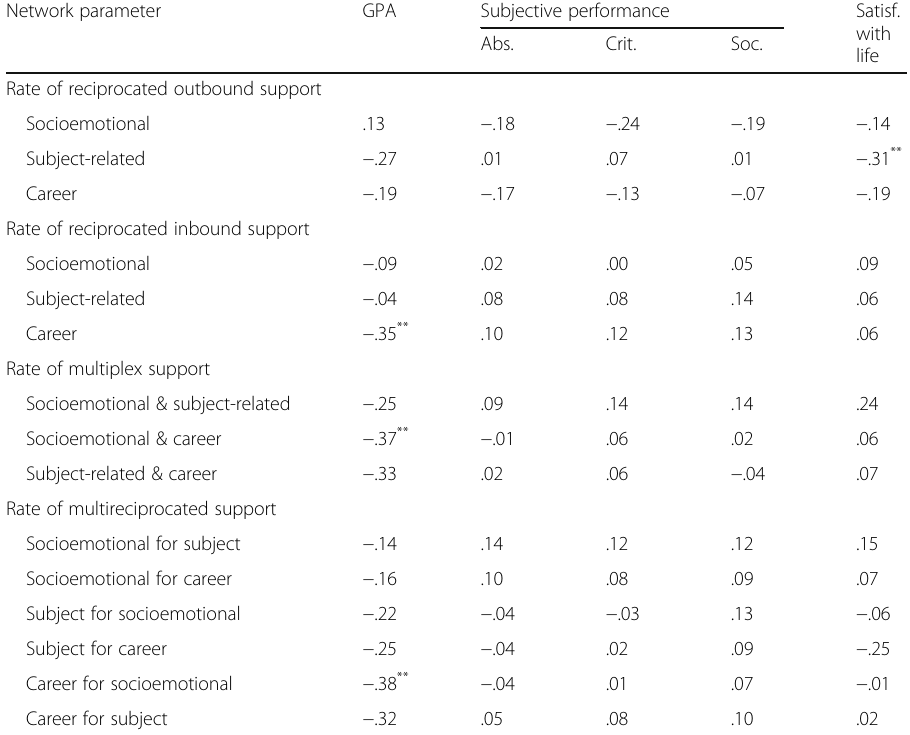
Table 3 Correlations of Rates of Reciprocity, Multiplexity and Multireciprocity with Career Outcomes Network